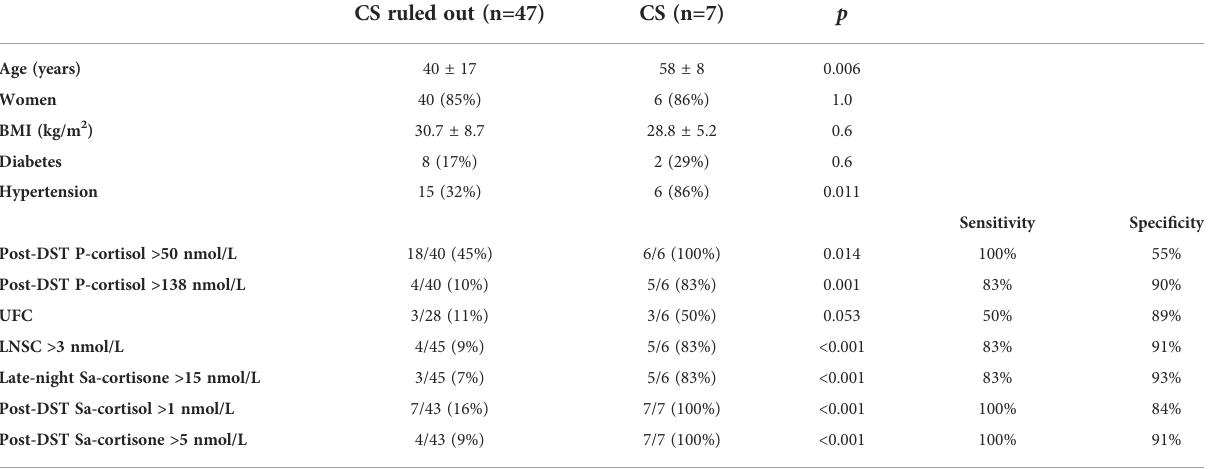
TABLE 3 Characteristics of patients with suspected Cushing ’ s